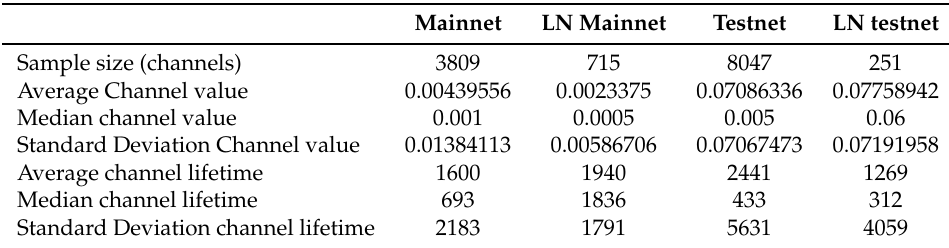
Table 1. Value and lifetime for channels.